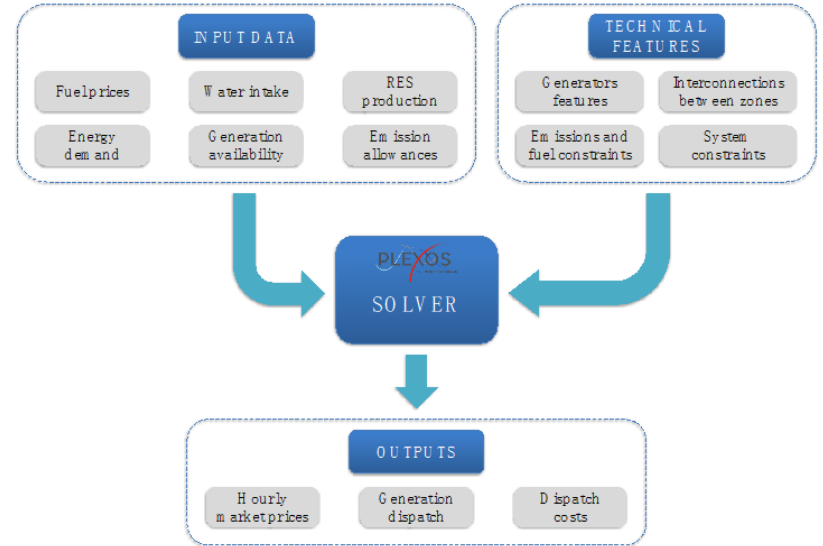
Figure 3. Energy market simulation model workflow.